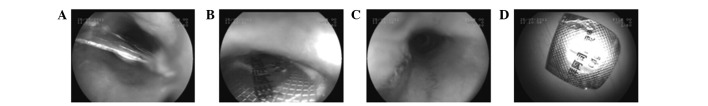
Images of the endoscopic management process for the removal of an encapsulated pill from a patient’s esophagus. (A) Shows a medication (aspirin tablet) with an outer plastic cover with both sides impacted in the esophageal cavity. (B) Shows the foreign body (reverse of the outer plastic cover) as viewed through the endoscope. (C) Shows the wound in the esophageal wall caused by the impacted medication following removal. (D) Shows that the medication and its plastic cover were removed successfully.